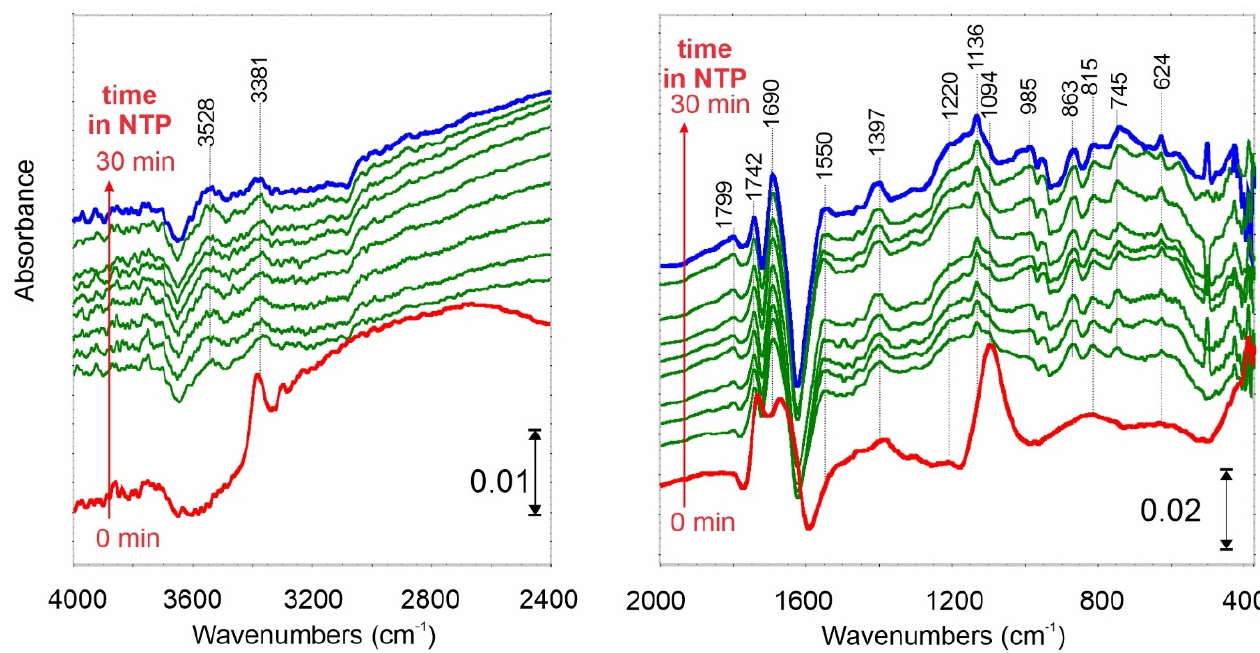
Figure 6. FTIR differential spectrum of C des N carbon film after NH 3 adsorption at 25 °C (red spectrum—0 min) and time-resolved spectra when NTP is switched on from 0 to 30 min.